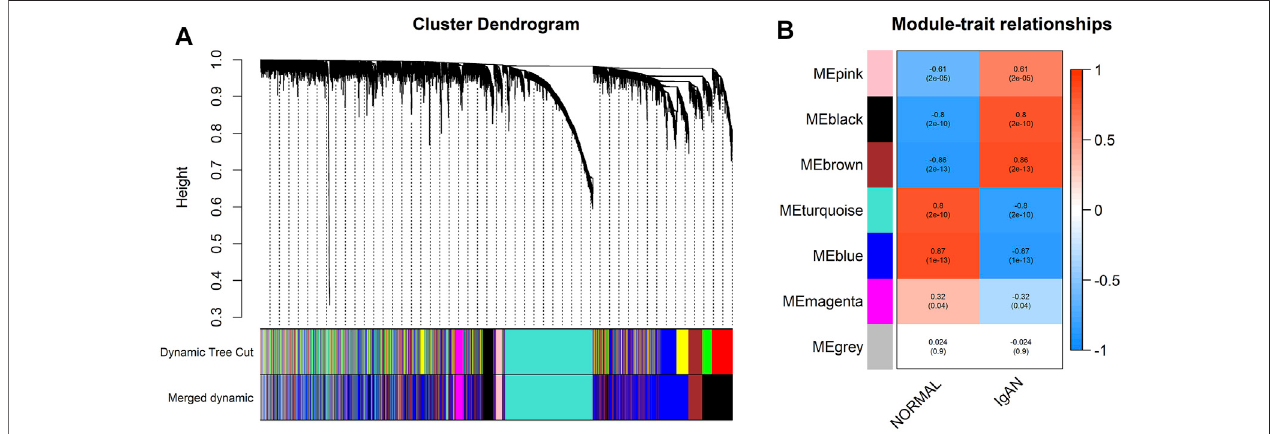
FIGURE4| Divisionandidenti fi cationoftheco-expressionnetwork. (A) Clusterdendrogram ofallgenesbasedonadissimilaritymeasure. Themoduleslabeledby color are displayed at the bottom. (B) Heatmap ofmodule – traitcorrelations.Each column containsthe correlation coef fi cients and statistical signi fi cance. The black and brown modules were identi fi ed as IgAN-related